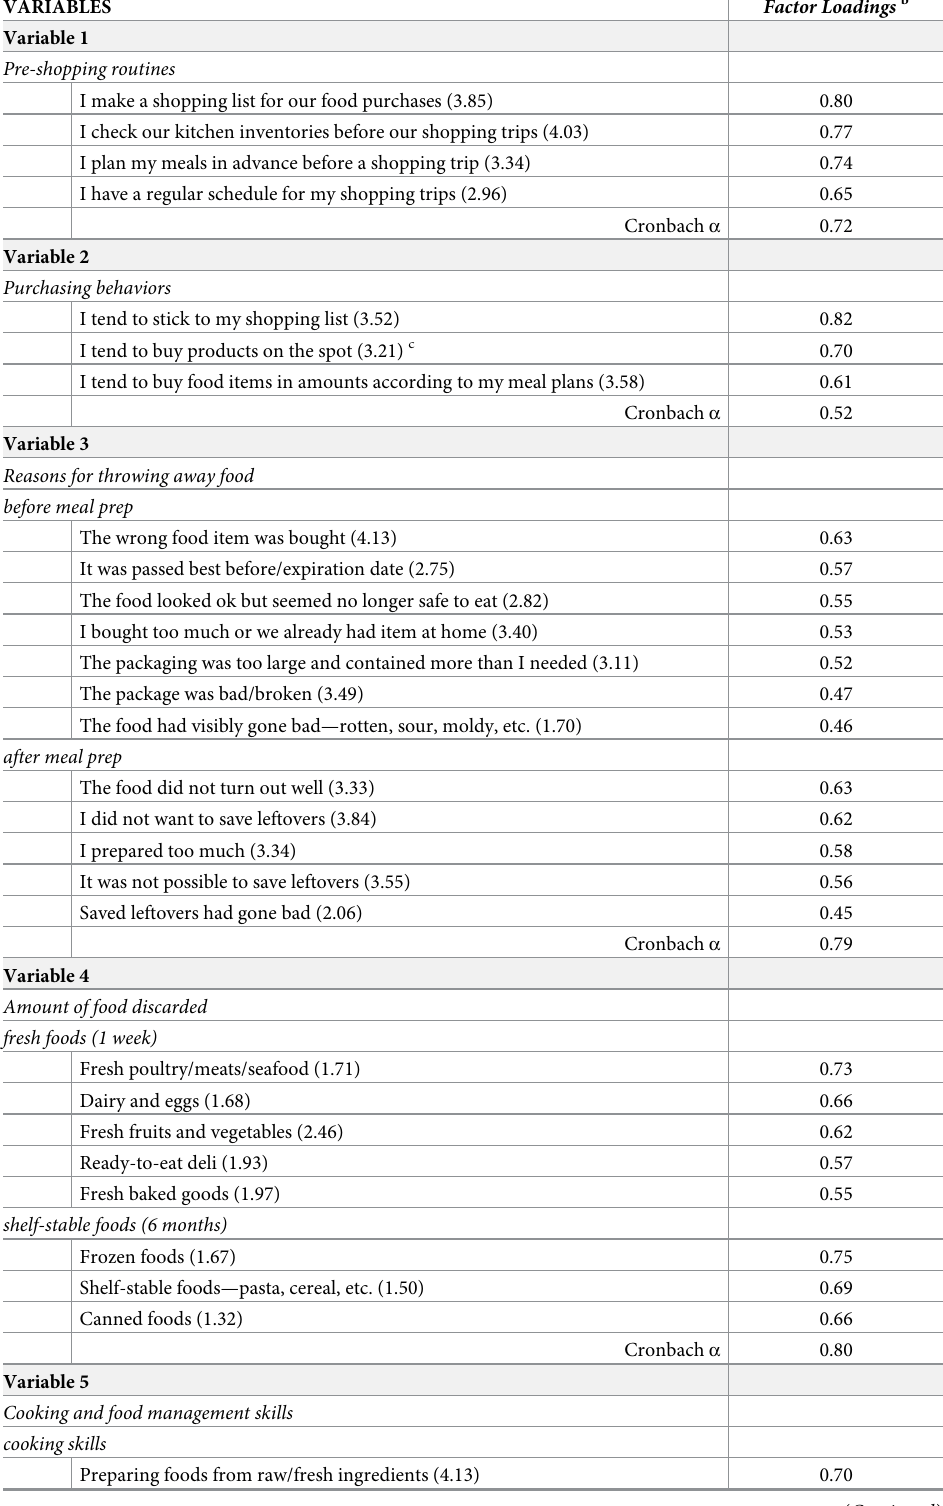
Table 3. Means, factor variables, loadings and Cronbach α (alpha) a